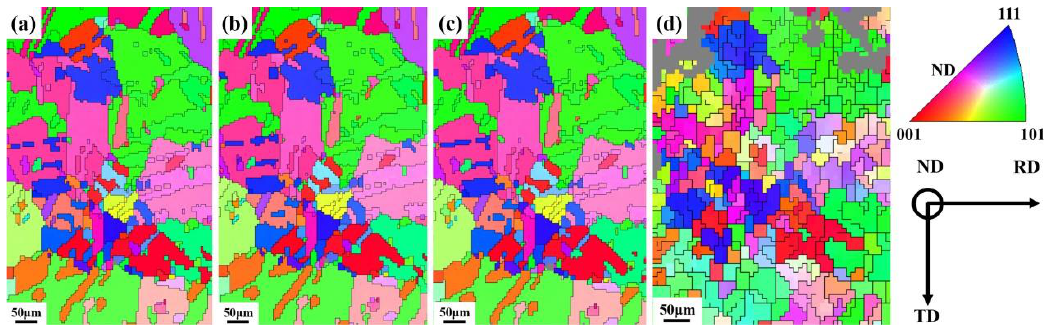
Figure 4. The EBSD Inverse Pole Figure (IPF) maps the same region of the specimen at different true strains: ( a ) 0, ( b ) 0.009, ( c ) 0.024, ( d ) 0.09. (RD: rolling direction, ND: normal direction, and TD: transverse direction; the IPF maps are plotted in the ND direction of the specimen).